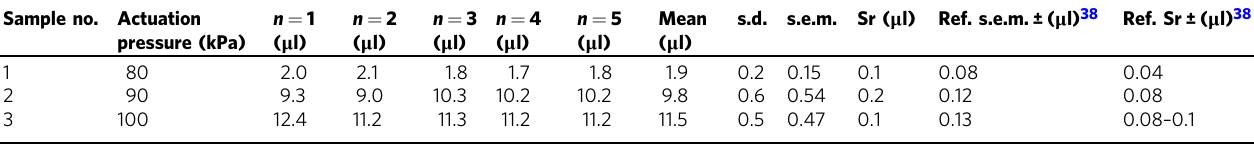
Table 2 Micro-dispenser dispensing accuracy in pressure-driven systems Sample no. Actuation pressure